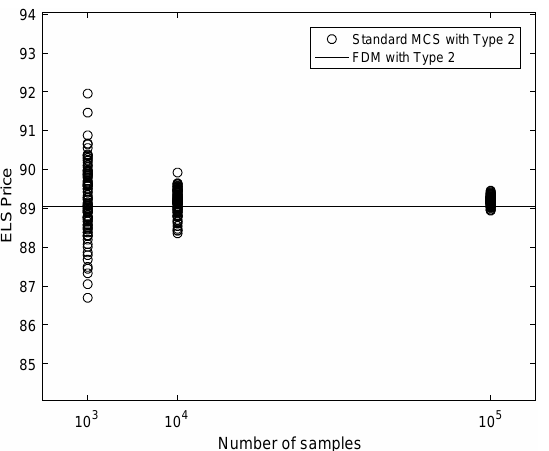
Figure 7. The type 2 ELS price versus the number of samples. Here, we plot 100 simulation results for each case.